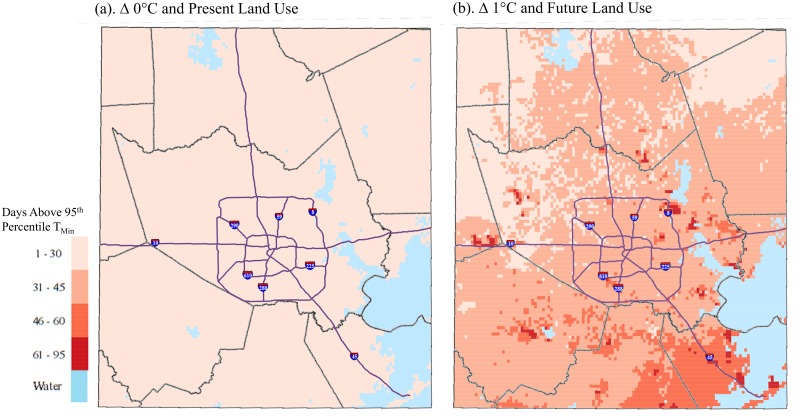
Average annual number of May-September days exceeding the 95th Percentile of Tmin for (a) the baseline scenario and (b) the combined climate and land use change scenario, 1-km grid, Houston study area.